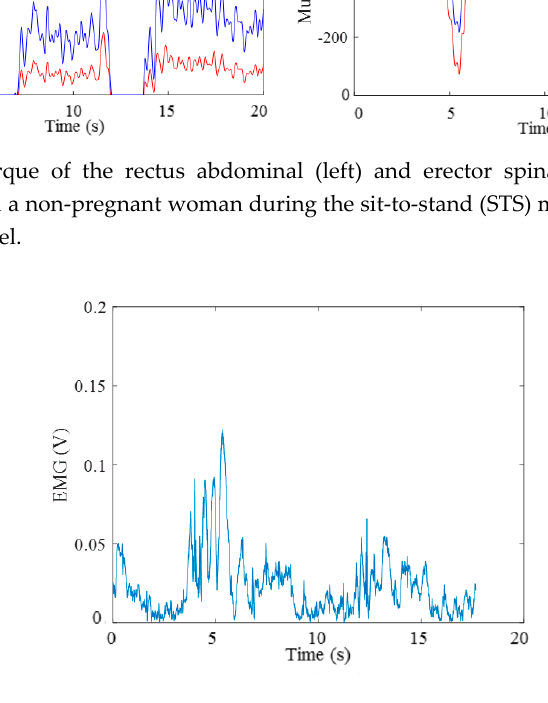
Figure 9. Results of muscle activation patterns of the rectus abdominis with